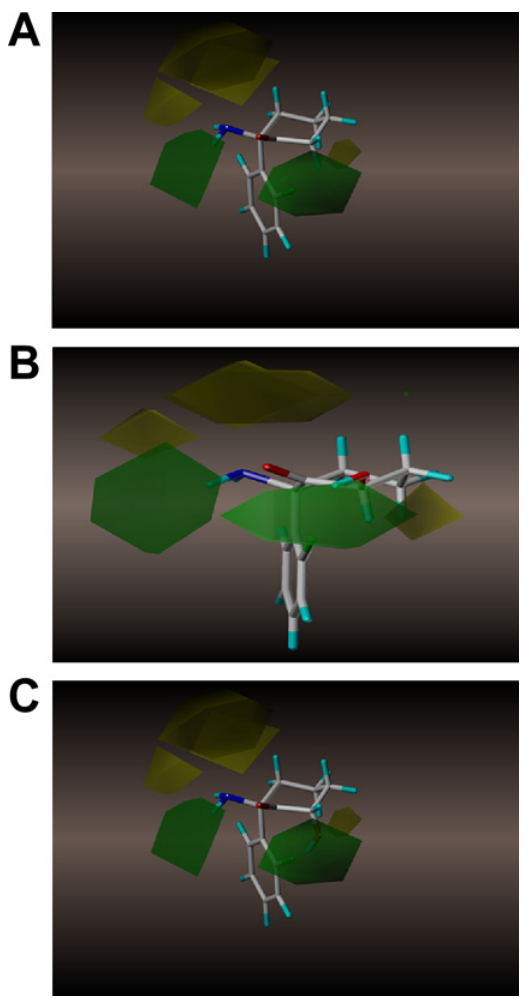
Fig 3. CoMFA models derived from the potency (determined as IC 50 value) of ketamine metabolites on intracellular D-Ser concentrations. Nine compounds were considered in this study. The inclusion of (R)- norKet ( A ); (2R,6R)-HNK ( B ) and (2R,6S)-HNK ( C ) are